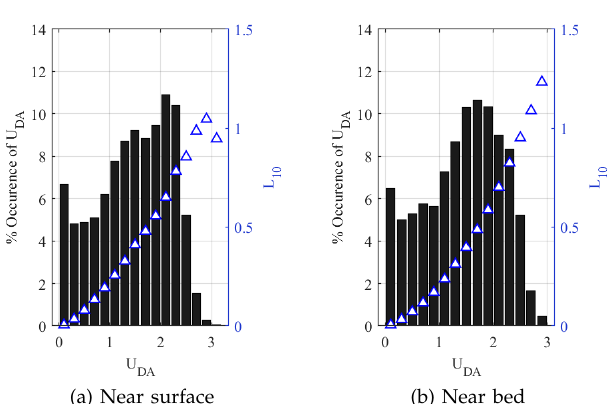
Fig. 8. Normalised damage equivalent loads for one velocity bin varying and mean measured profiles and predicted profiles, with constant mean fluctuation intensity (a) for the near-surface turbine position, (b) for the near-bed turbine position, dashed lines to rep- resent the measured varying case with varying fluctuation intensity.